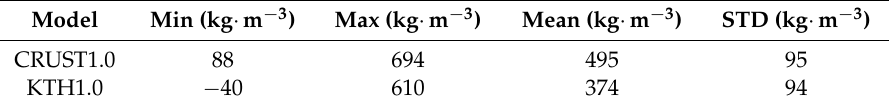
Table 4. Statistics of the Moho depth from the CRUST1.0, KTH1.0, GSMM, M13 and GEMMA models.